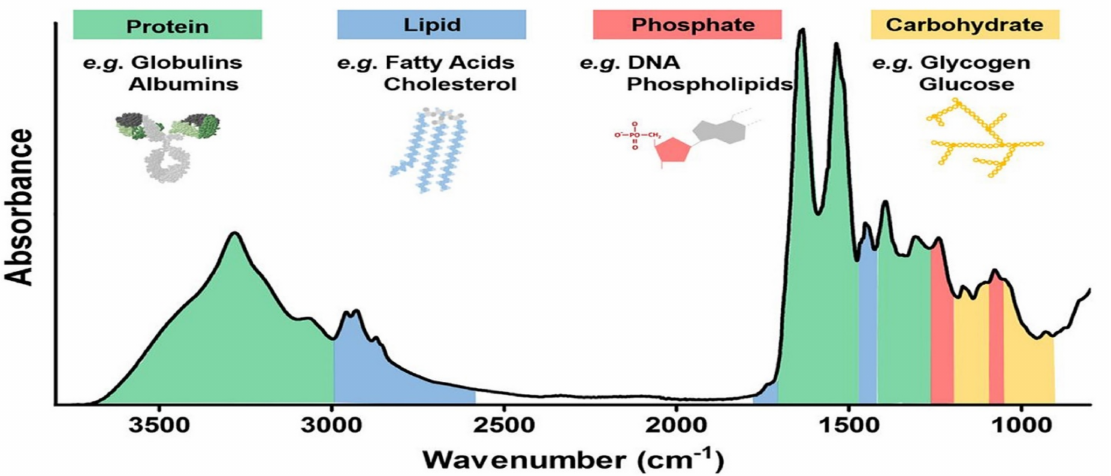
Figure 4. FTIR spectroscopy for biomolecules in human blood. Reprinted by permission from [41]. Copyright 2020